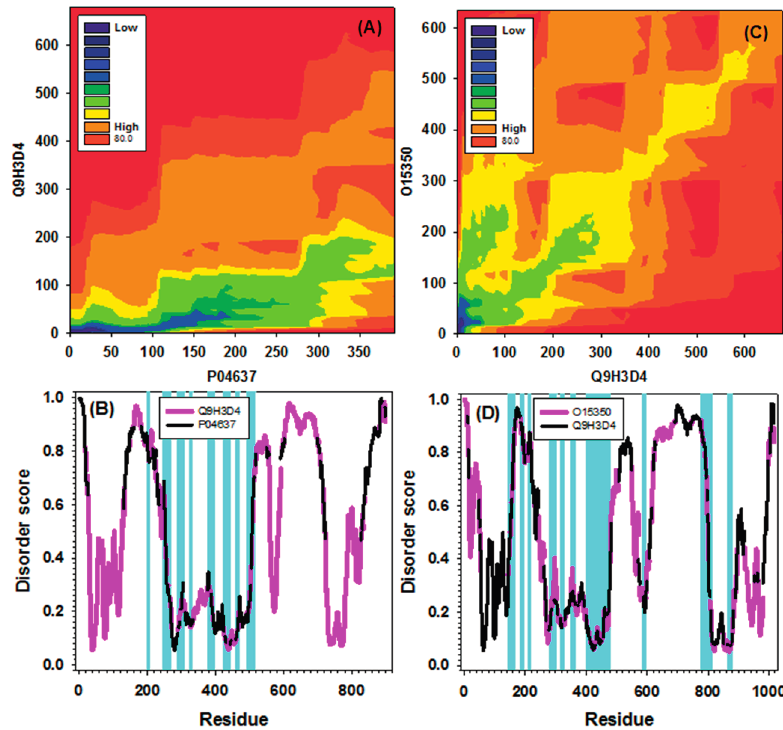
Figure 8. Identified alignment paths and alignments for sequence pairs between human p53 (Uniprot ID: P04637) and human p63 (Uniprot ID: Q9H3D4) in ( A , B ), and between human p63 and human p73 (Uniprot ID: O15350) in ( C , D ), respectively. ( A , C ) Alignment paths (contour maps) between two sequences in each of the sequence pairs were identified by our newly developed package; ( B , D ) Alignment of disorder curves along the alignment paths for two sequence pairs: Q9H3D4 (pink) and P04637 (black) in ( B ); O15350 (pink) and Q9H3D4 (black) in ( D ). Only overlapped segment pairs of which the distance less than 0.05 were highlighted by cyan.